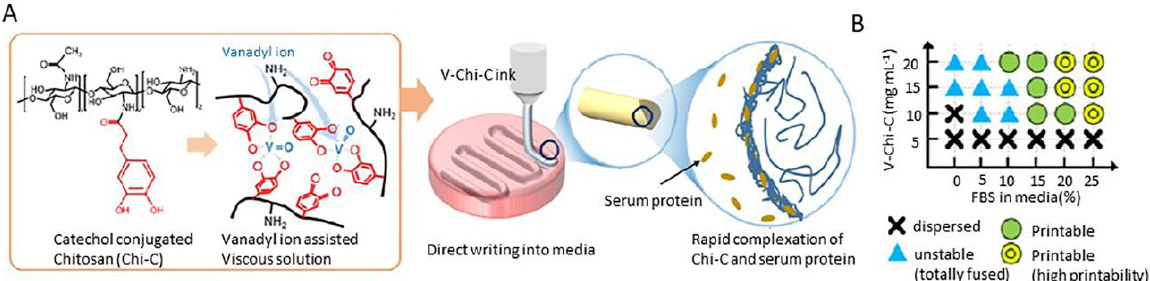
Figure 19. ( A ) Catechol-chitosan ink with vanadyl ions (V-Chi-C). ( B ) Preparation of the ink and 3D printing process. Reproduced from [55] Copyright 2018, The Royal Society of Chemistry.